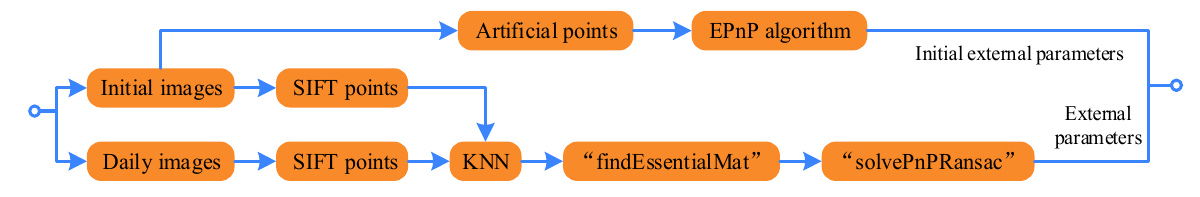
Figure 3. Calibration of external parameters.